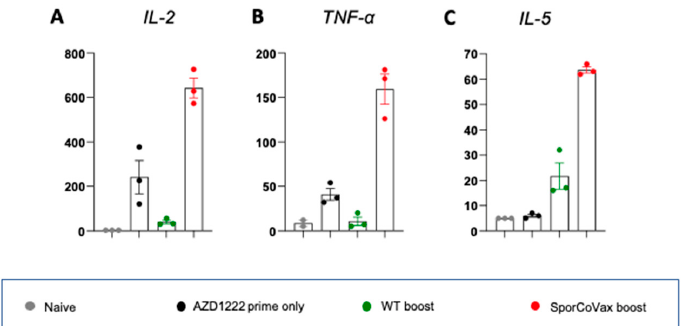
Figure 4. Cytokine profiles. BALB/C mice (female, aged 8 weeks; n = 3/gp) were immunized with AZD1222 (i.m.; 1.0 × 10 8 IU) followed by two intranasal boosts with spores (1 × 10 9 CFU/dose) of WT or SporCoVax (a 1:1 mixture of CotB-RBD Wuh and CotC-HR1-HR2 Wuh ) three and five weeks post prime immunization. Control groups included untreated animals (naïve) and animals primed only (AZD1222). All mice were sacrificed 48 days post prime, and their spleens dissected and stimulated with 2.5 μ g/mL rS Wuh protein for 72 h, and levels of the cytokines IL-2 (panel A ), TNF- α (panel B ) and IL-5 (panel C ) determined by flow cytometry.